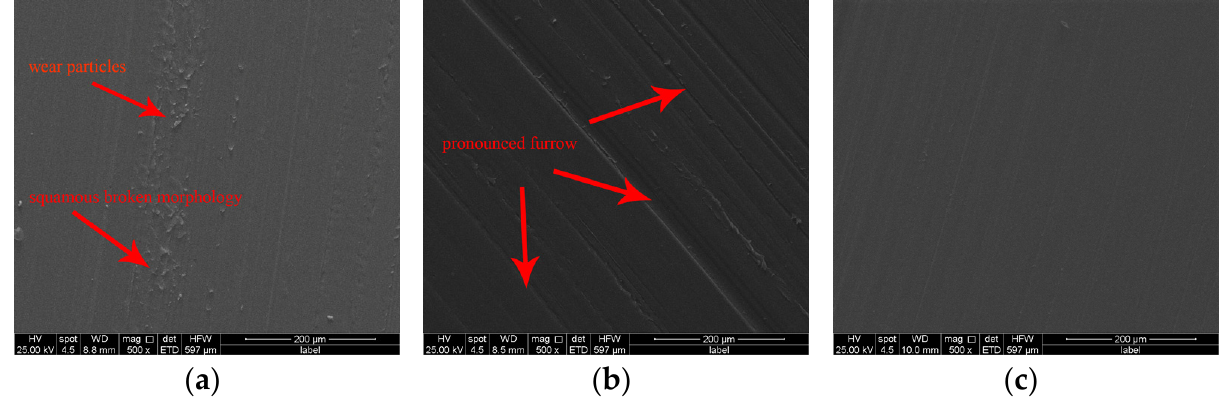
Figure 5. SEM images of worn surface of the PEEK disc against the SN20 pin at the following different